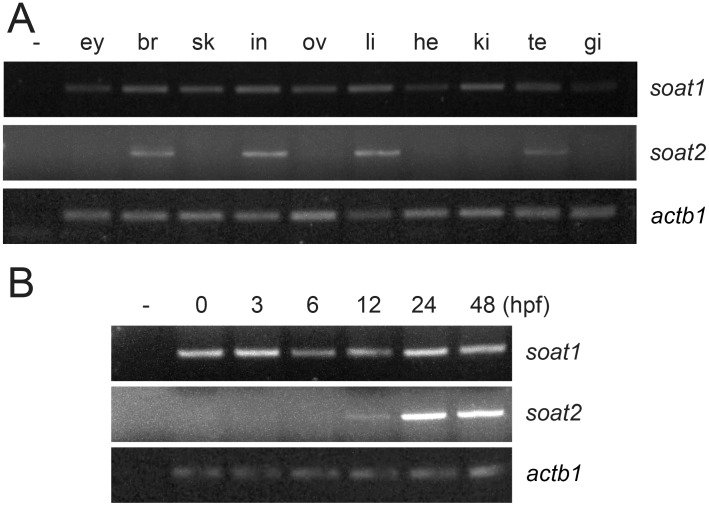
Distinct expression profiles of soat1 and soat2.RT-PCR analysis using cDNA collected from zebrafish adult tissue (A) and embryos (B) indicated that soat1 is expressed ubiquitously in every tissue tested, including the eye (ey), brain (br), skin (sk), intestine (in), ovary (ov), liver (li), heart (he), kidney (ki), testis (te) and gill (gi), and could be detected at freshly laid eggs (0 hpf) through 48 hpf. Soat2 is expressed only in the brain, liver, intestine and testis in the adult zebrafish, and could not be detected until 12 hpf in the embryos. β-actin served as loading control while the reaction without template (-) served as negative control.